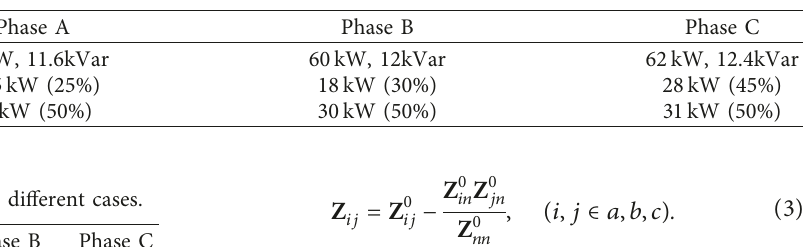
Figure 4: Recorded one-month voltage profile at the secondary side of an 11kV/415V Table 1: Load and PV installation capacity.